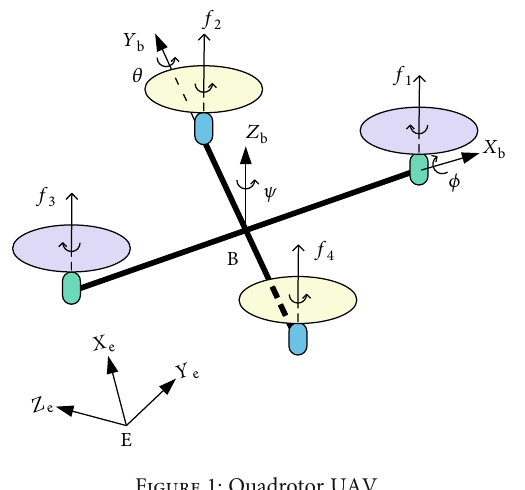
Figure 1: Quadrotor